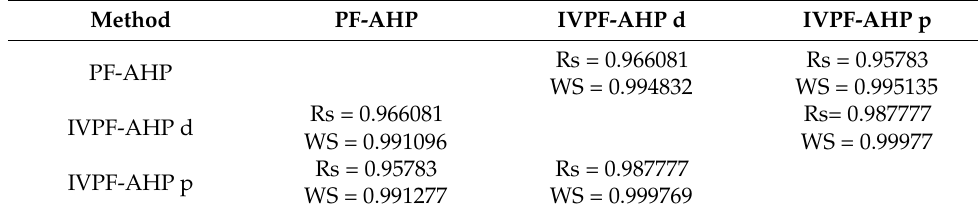
Table 18. Ranking